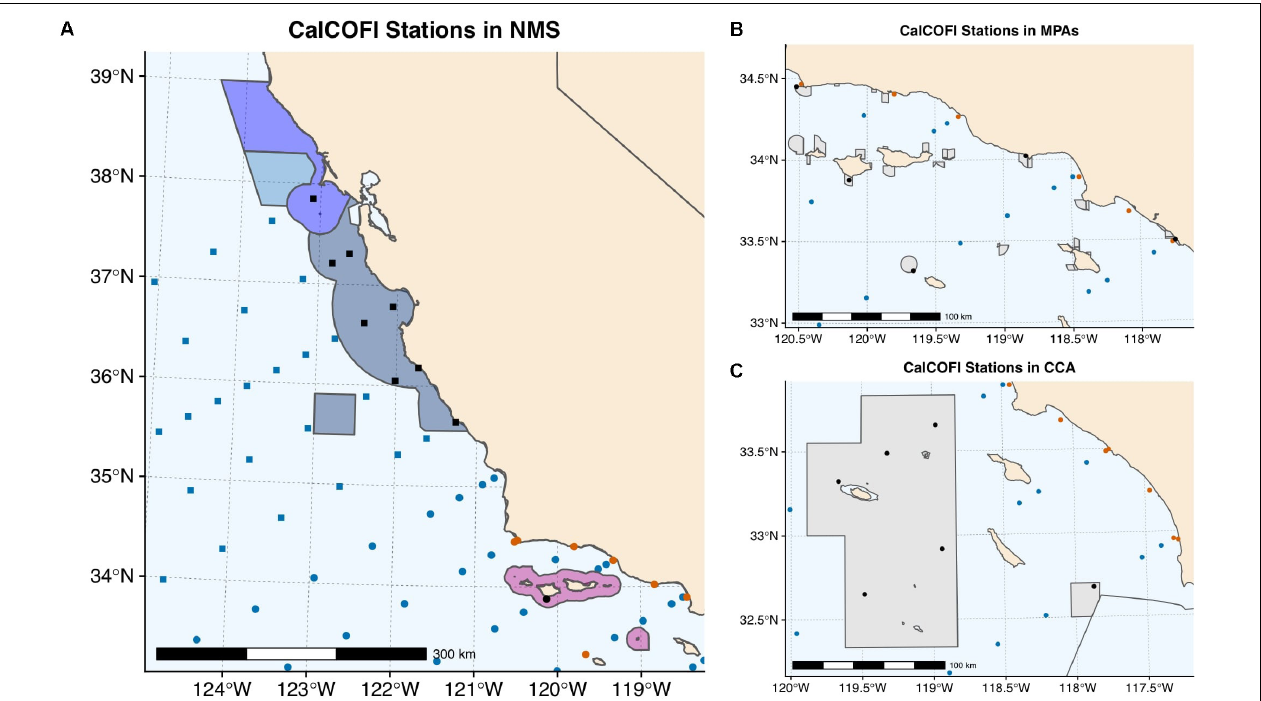
FIGURE 6 | Nine CalCOFI stations fall within the National Marine Sanctuaries (A) , five within Marine Protected Areas (B) , and six within the Cowcod Conservation Area (C) . CalCOFI stations that fall within conservation areas are shown in black within the conservation area boundaries. A scale bar is provided for spatial reference. Color and point type of other CalCOFI stations are consistent with Figure 1